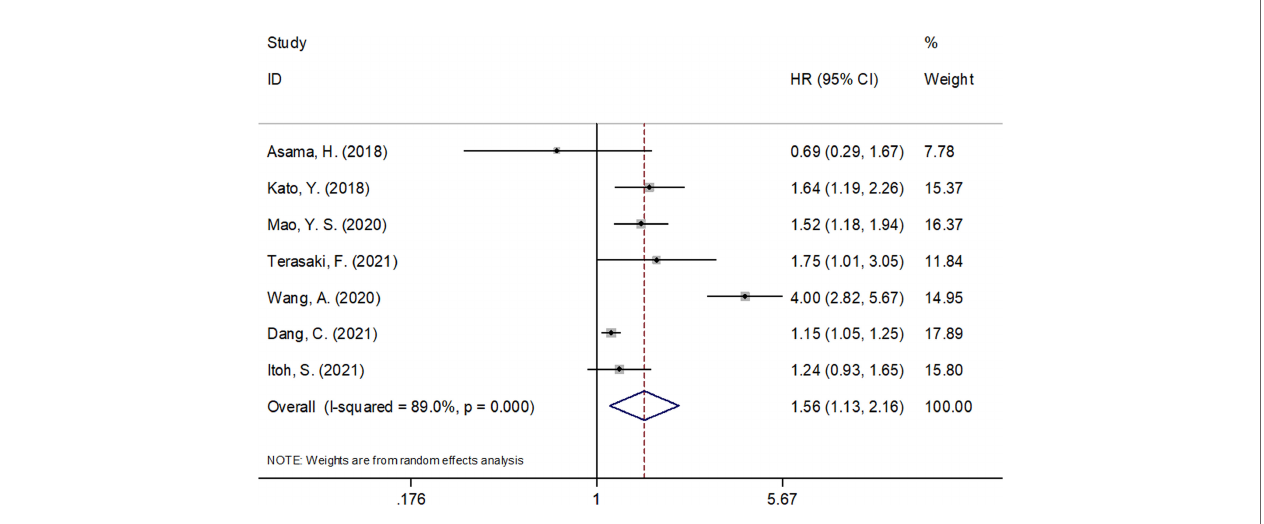
FIGURE 2 | Forest plots of CONUT score in predicting OS in pancreatic cancer.